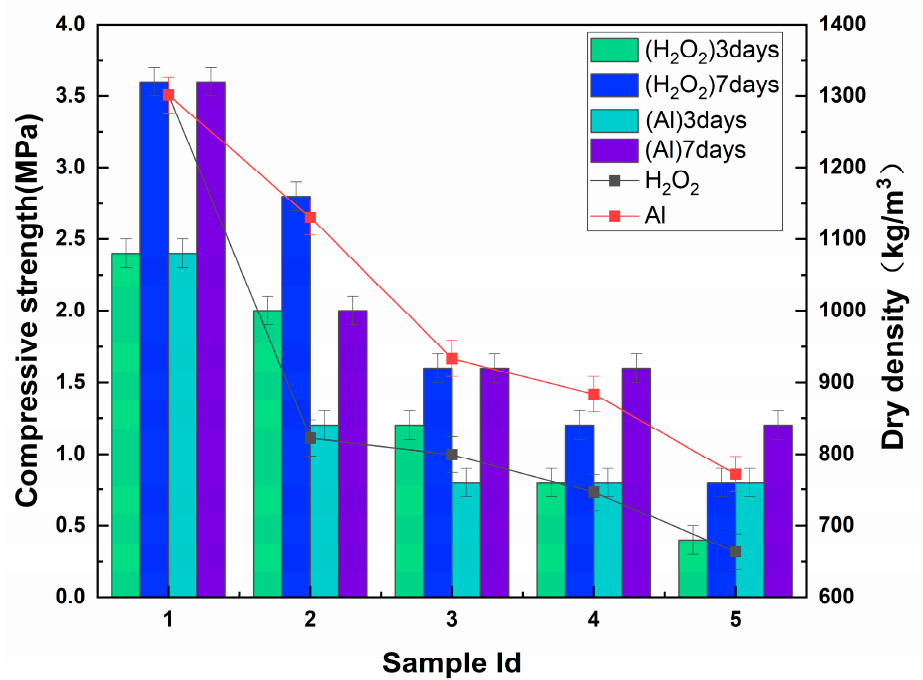
Figure 8. Relationship between the compressive strength and dry density of HMNS-FA-phosphate- based porous